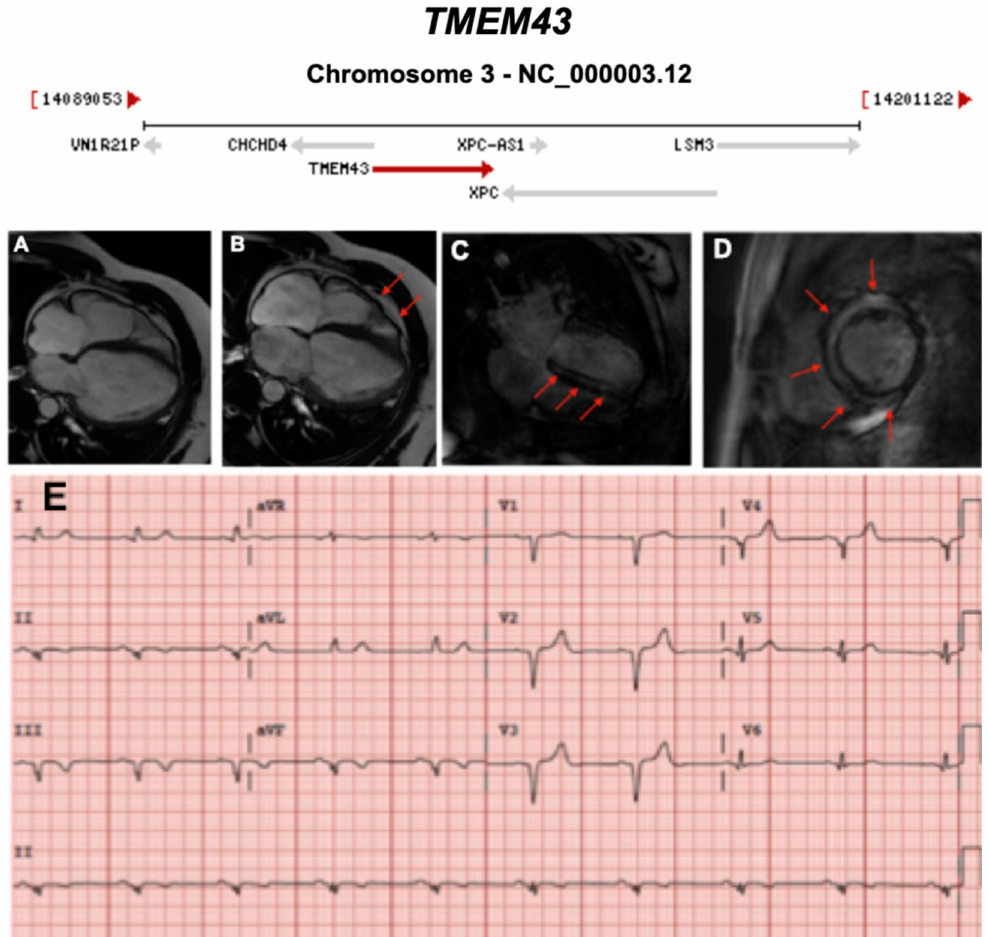
Figure 15. Exemplar MRI and ECG finding found in ACM patients with TMEM43 mutations. ( A – D ): CMR images of a male subject with TMEM43 p.S358L mutation. ( A ) Biventricular dilatation, wall motion abnormalities; ( B ) asynchronous contraction (red arrows); ( C , D ) LGE showing severe and almost concentric intra-myocardial lesions (red arrows); ( E ) a representative 12-lead ECG of a different patient with the same TMEM43 mutation, showing poor R-wave progression with 1-mV R-wave voltage in lead V3 and widened QRS complex. Reproduced with permission from Dominguez et al. (2020)